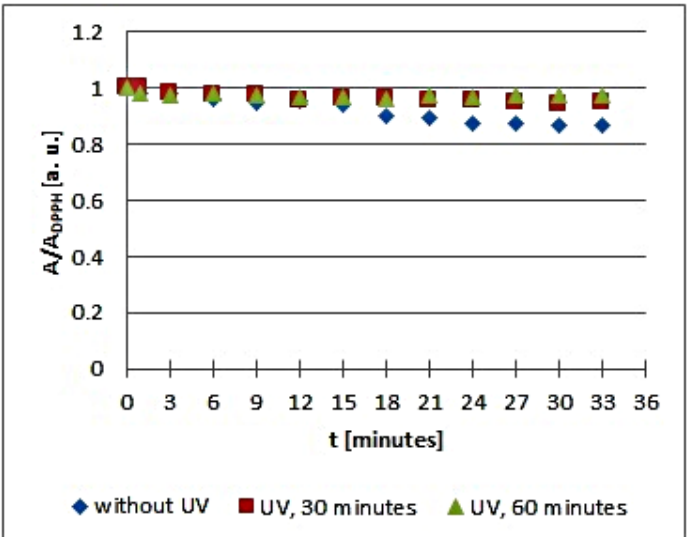
Figure 5. Changes of the relative amplitude (A/A DPPH ) of EPR spectra of DPPH free radicals with increasing time of interactions ( t ) with infusions of the root of Asparagus racemosus . A—amplitude of the EPR line of DPPH free radicals in contact with the tested samples. A DPPH —amplitude of the EPR line of DPPH free radicals in the reference solution. For the reference solution, the relative amplitude (A/A DPPH ) takes the values 1. Data for the infusions obtained from the plant materials exposed to UVA radiation for 30 and 60 min are presented. For comparison, data for the infusions of the plant material that was not exposed to UVA radiation are also